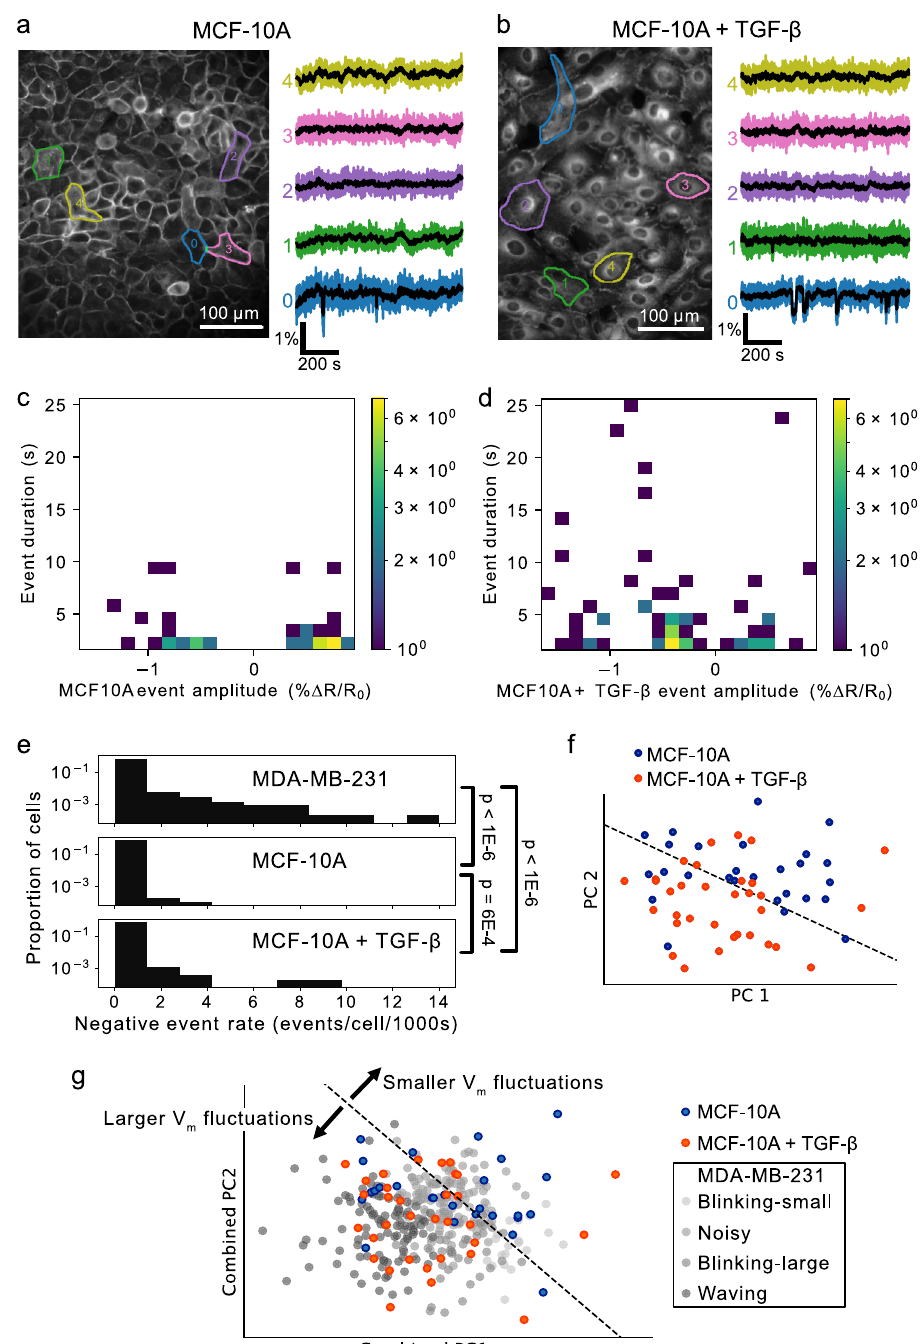
Fig. 8 Non-cancerous MCF-10A cells exhibit minimal V m fl uctuations which are upregulated by TGF- β . a , b Images and cellular V m time series extracted fromMCF-10A cells( a ) and MCF-10Atreated with TGF- β ( b ). c , d 2Dlog-scaled amplitude-duration histogramsof c MCF-10A and d MCF-10A + TGF- β events. Both MCF-10A and MCF-10A + TGF- β exhibit signi fi cantly lower event rates than MDA-MB-231 cells. e Cell-level comparison of the negative event rate. Incubation of cells with TGF- β signi fi cantly increases the event rate. f Incubation of MCF-10A in TGF- β alters the cellular-level DES. The treated and untreated cells locate in different areas of 2D PC space, indicating DES differentiation between these groups. The black dashed line is the best linear separator calculated on the TGF- β treated (orange) and untreated (blue) groups. g Unlike the untreated MCF-10A which exhibited V m fl uctuations of varying amplitudes, TGF- β treatment biased active MCF-10A V m fl uctuations such that they localized near the large-amplitude "waving ’’ MDA-MB-231 class in combined PC